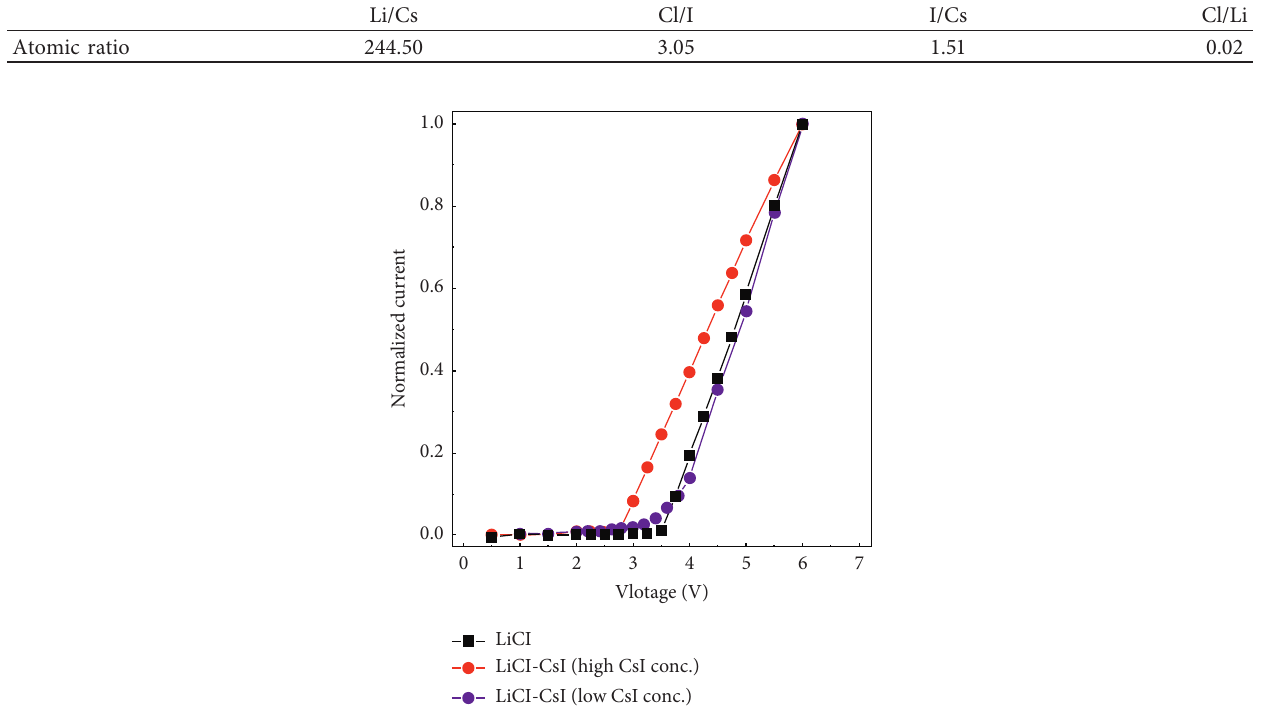
Figure 4: Normalized current-voltage characteristics of the LiCl and LiCl-CsI molten salts with the different CsI concentrations.